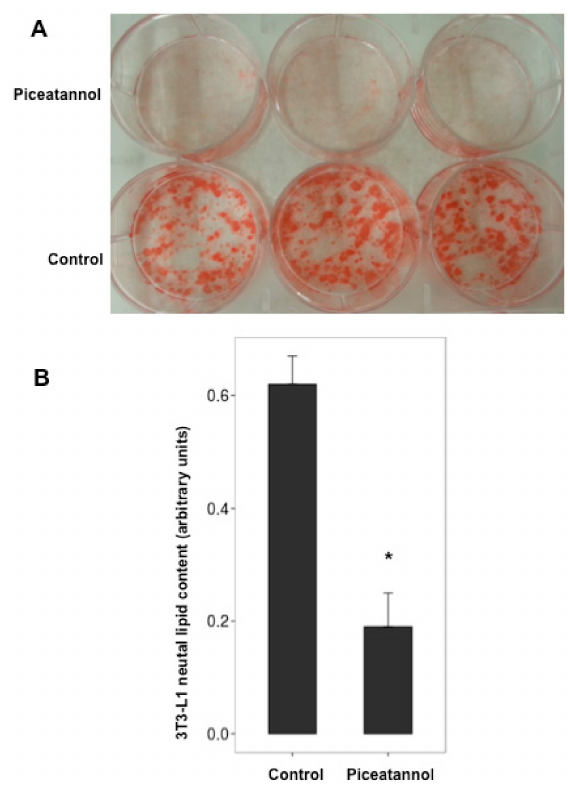
Figure 1. Influence of piceatannol on lipid accumulation in 3T3-L1 derived adipocytes. ( A ) Oil Red O staining of the mature adipocytes cultured in multi-well plates after differentiation without (control) or with 50 µ M piceatannol. ( B ) Quantitative analysis of neutral lipid content. Mean ± SEM of six determinations. Different from control at * p < 0.05 by Student’s t -test.